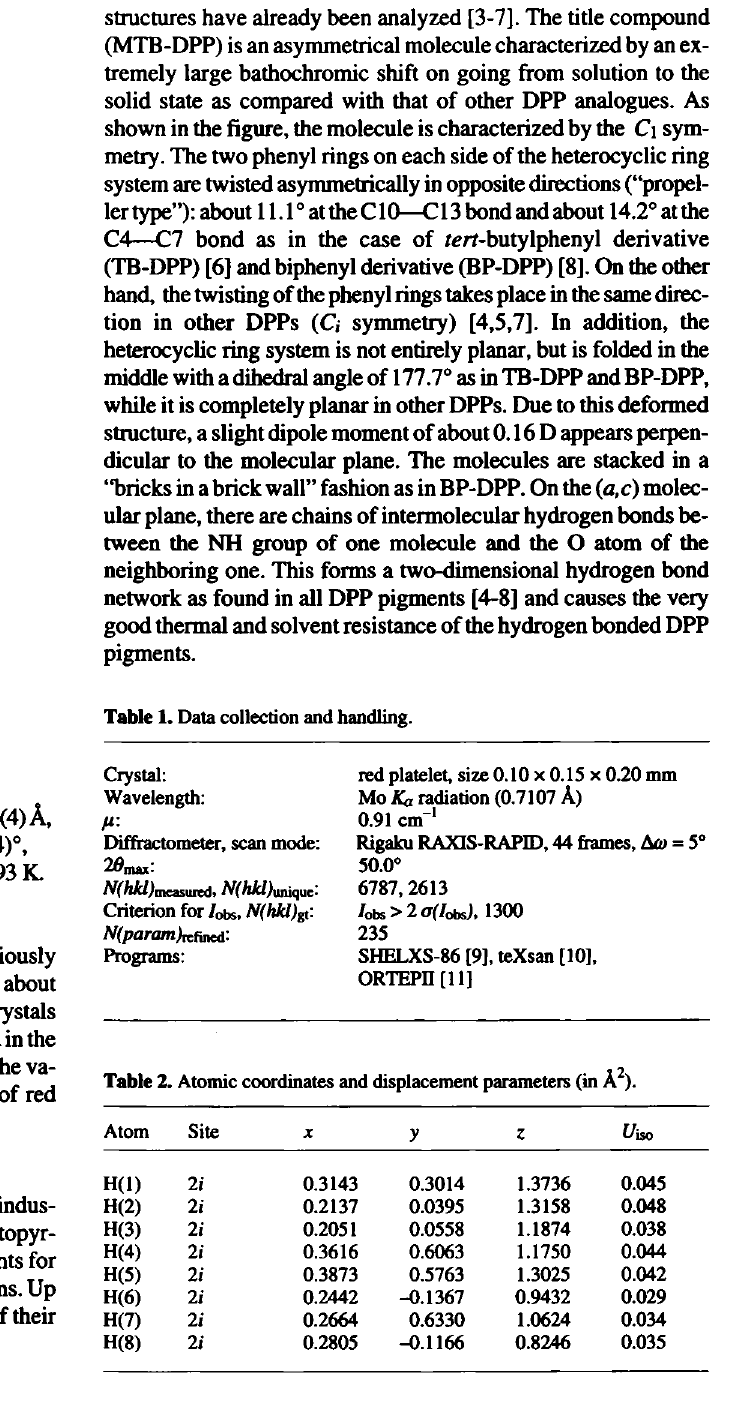
Table 2. Atomic coordinates and displacement parameters (in Â 2